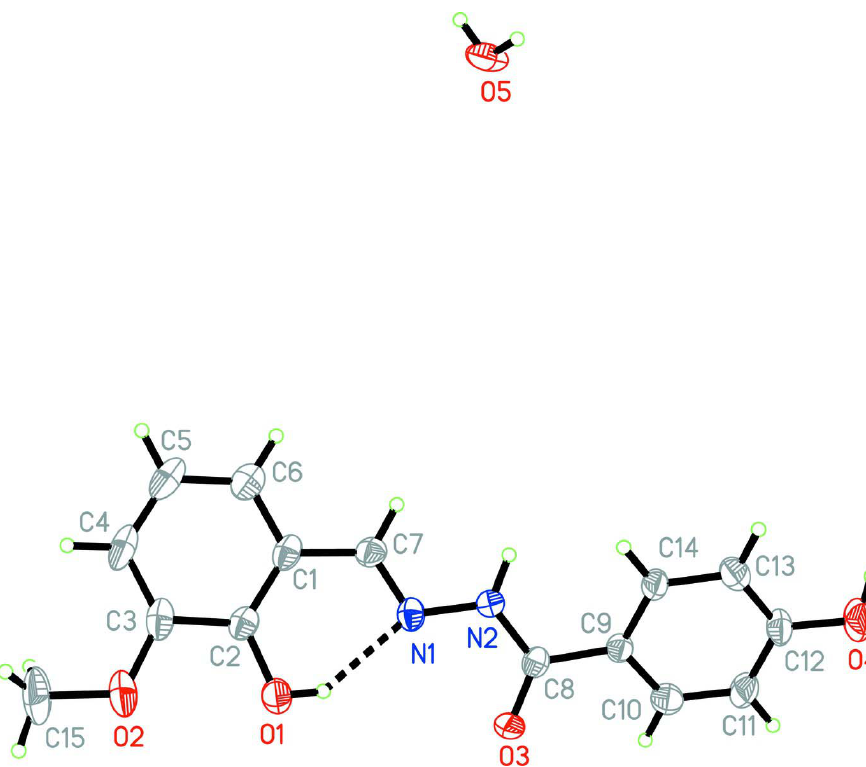
Figure 1 The molecular structure of the title compound, showing 30% probability displacement ellipsoids and the atom-numbering scheme. The dashed line indicates a hydrogen